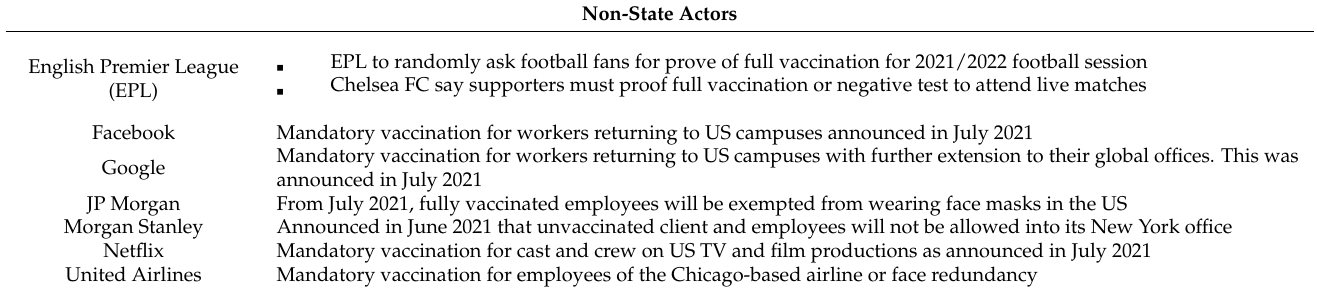
Table 1. Examples of state and non-state actors implementing/planning vaccine passport policies (VPPs).